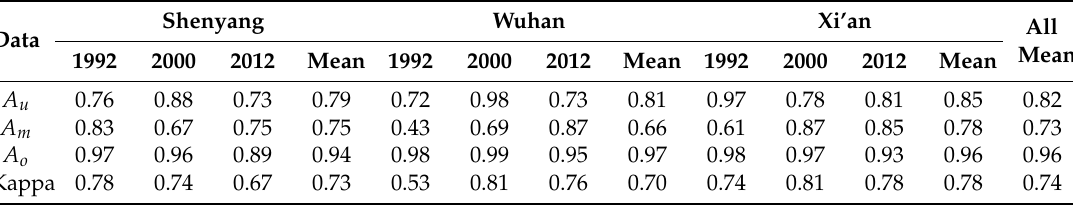
Table 11. Confusion matrix of the built-up area extraction method that uses ISODATA with Landsat data. Shenyang Wuhan Data